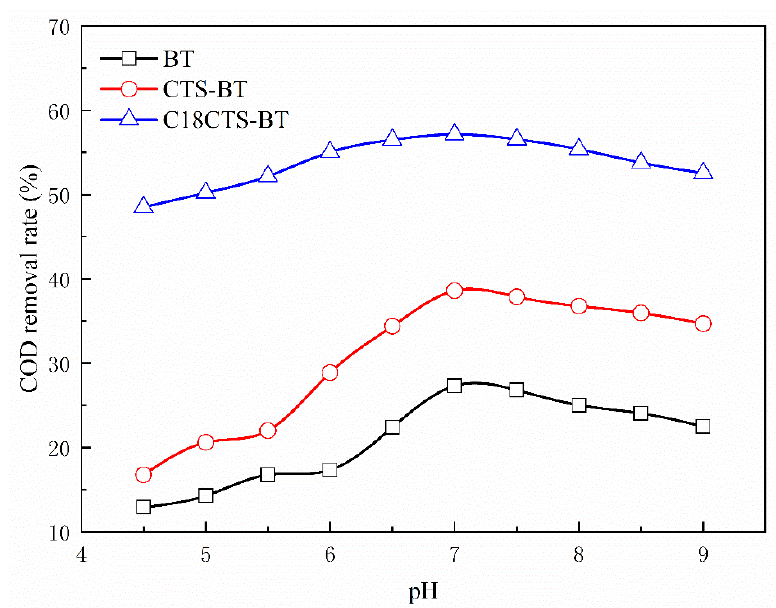
Figure 7. Effect of pH value on removal rate of COD (adsorbent dosage is 1.5 g · L − 1 ; adsorption time is 2 h).